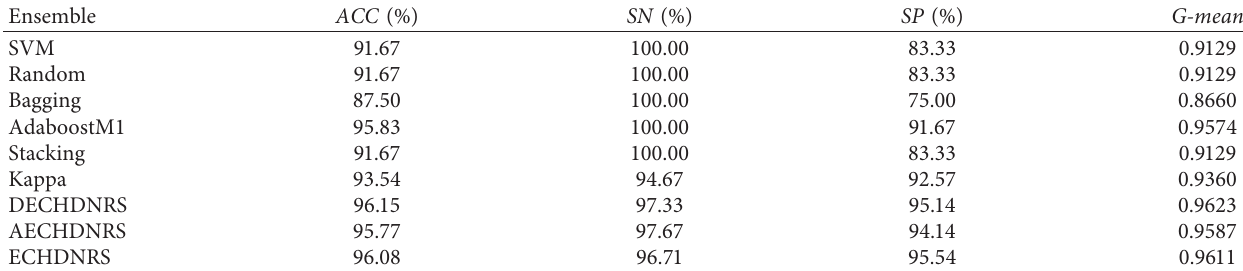
Figure 7: Distance between classifiers and centroids. Table 5: Classification results on Arabidopsis -Drought dataset.